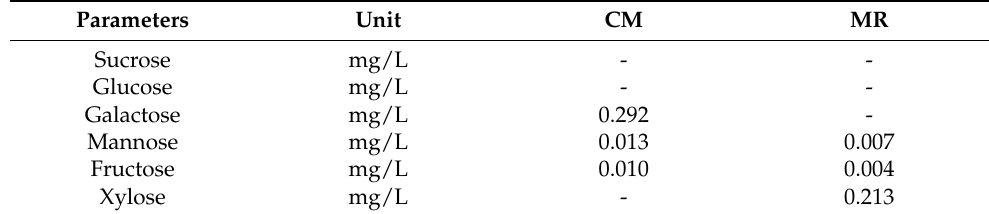
Table 2. Total Sugars in raw CM and